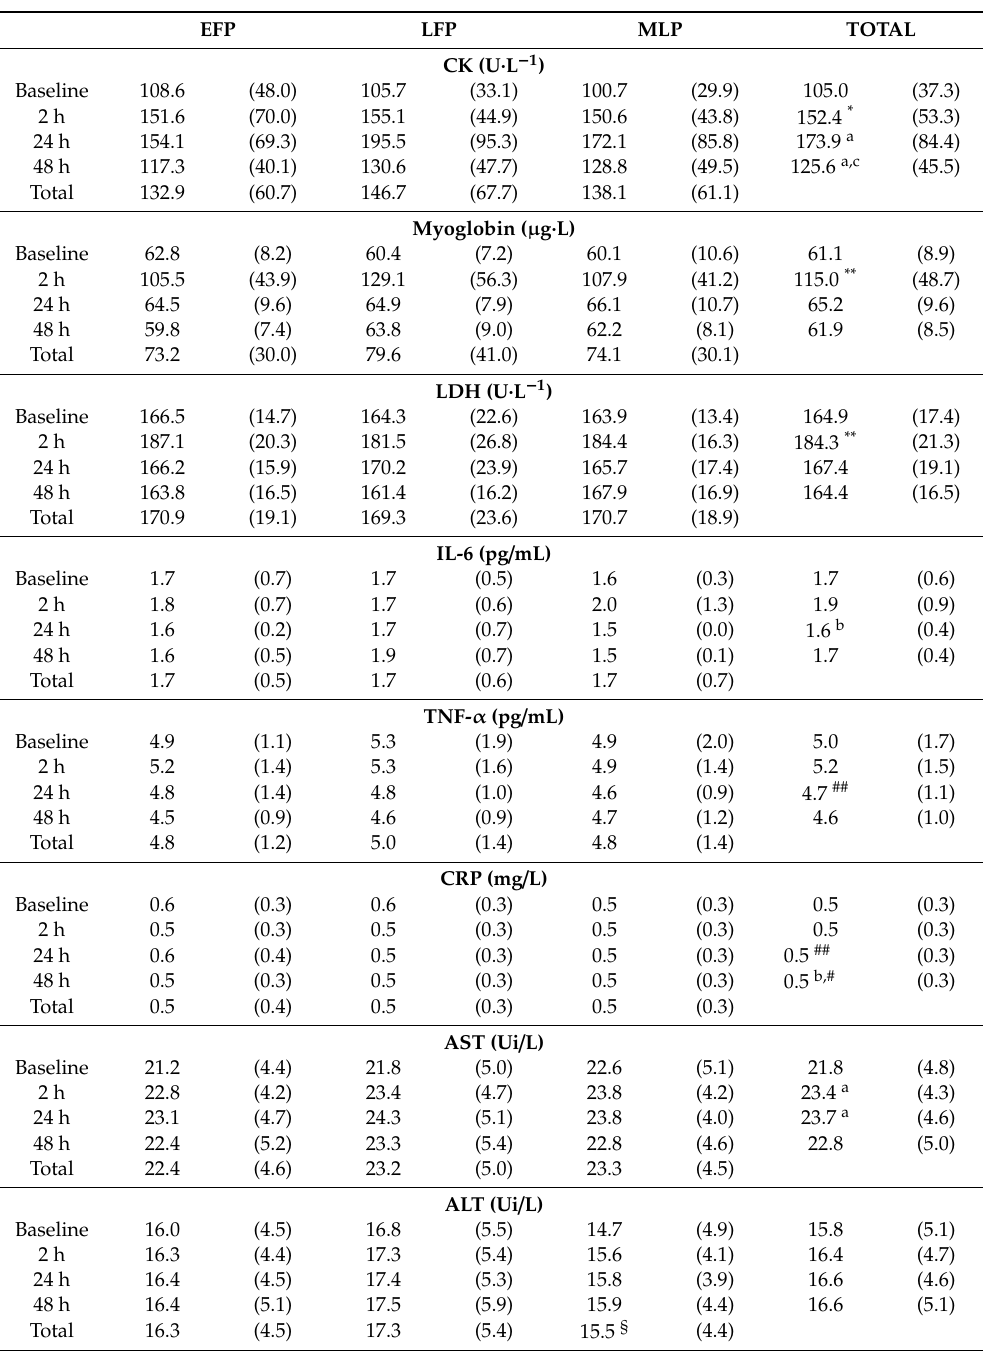
Table 1. Blood markers of muscle damage and inflammation throughout the menstrual cycle following an eccentric-based resistance exercise. Data expressed as mean